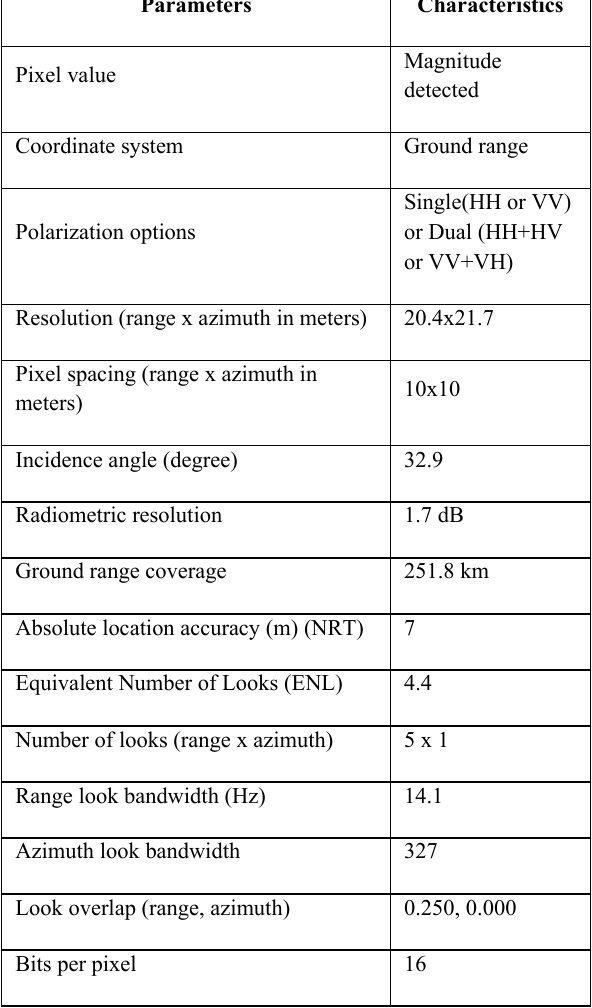
Table 1. Characteristics of Sentinel1-A (IW1-GRD-HR) Data (DeZan and Guarnieri., 2006)